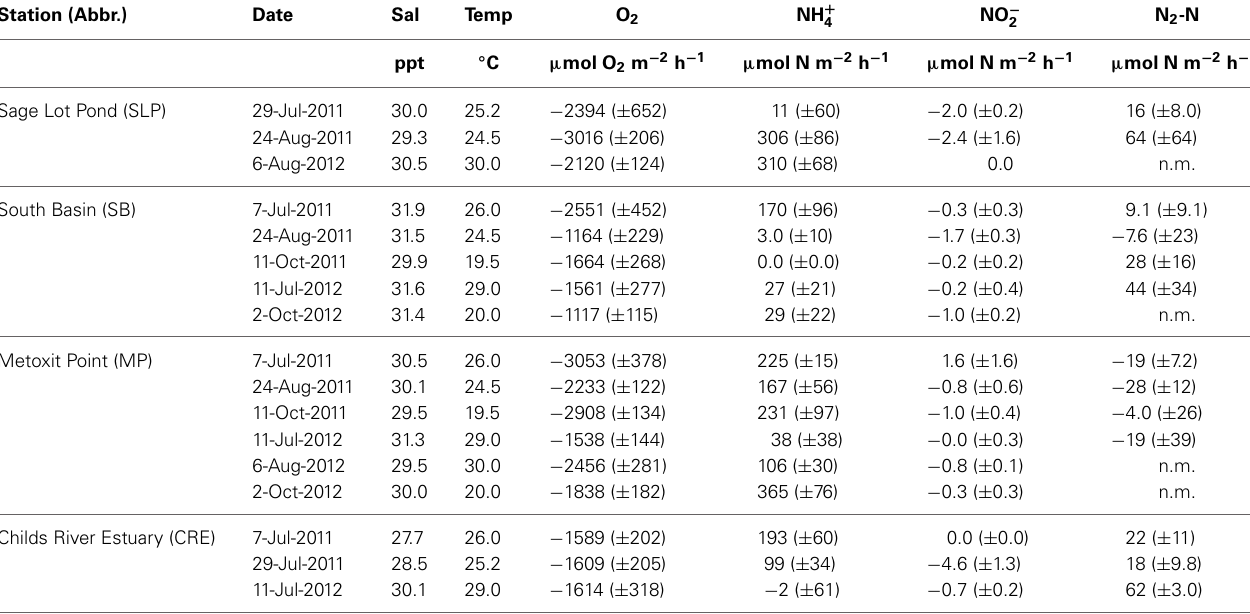
Table 2 | Summary of sediment oxygen (O 2 ), ammonium (NH + measured across the sediment-water interface in 2011 and 2012 (July–October).